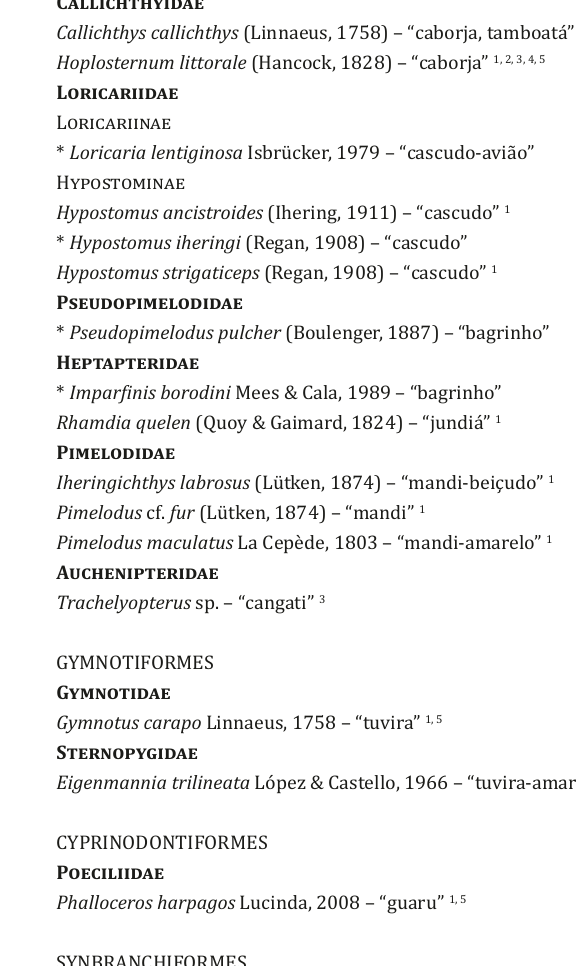
Table 1. Fish fauna from the area influenced by Mogi Guaçu reservoir and Mogi Guaçu Ecological Station (Campininha farm) oxbow lakes. (1) Mogi Guaçu reservoir; (2) Catingueiro lake; (3) Barrinha lake; (4) Pedra lake; (5) Fundão lake. Regional popular names of each species are provided between quotation marks. Species captured on Mogi Guaçu River, downstream reservoir, are marked with *. Taxonomic classification followed Buckup